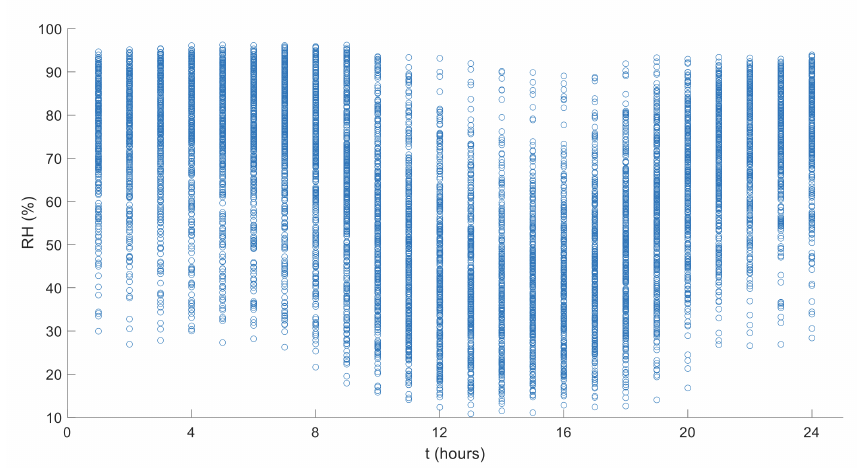
Figure 3. Annual variation of relative humidity.